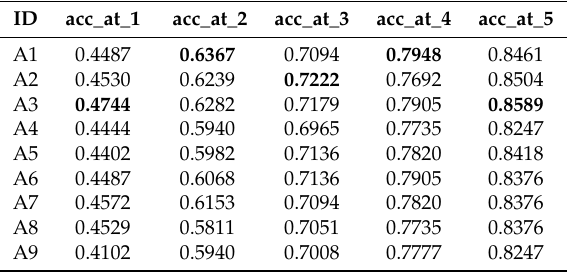
Table 3. Architecture experiments: Accuracy for different number of predictions.